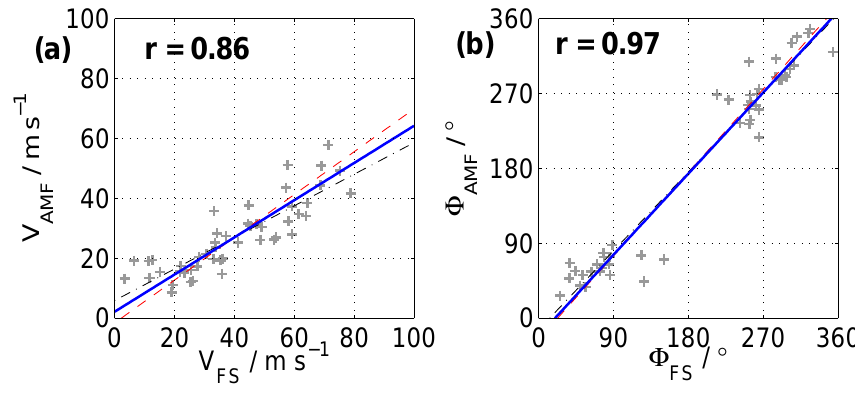
Fig. 5. Scatter plots of wind speed (a) and direction (b) from the spaced antenna experiment using the wide-beam Andenes MF radar ( V AMF ,8 AMF ) and falling spheres ( V FS ,8 FS ) for the altitude range below 80km.